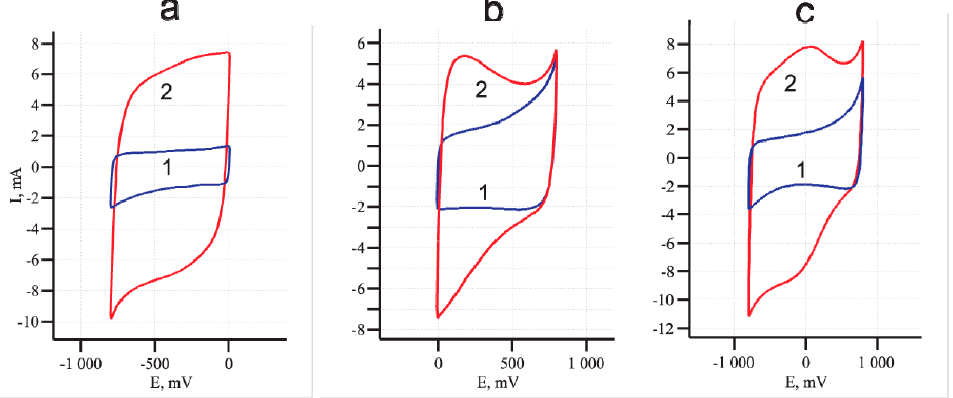
Figure 2. CVs of the MWCNT/Al foil in the three-electrode cell. Before electrochemical modification (1) and after anodic oxidation at 5 V for 20 min in 0.005 M aqueous Na 2 SO 4 solution (2). Voltage scanning range: ( a ) From − 800 to 10 mV; ( b ) From − 10 to 800 mV; ( c ) From − 800 to 800 mV.